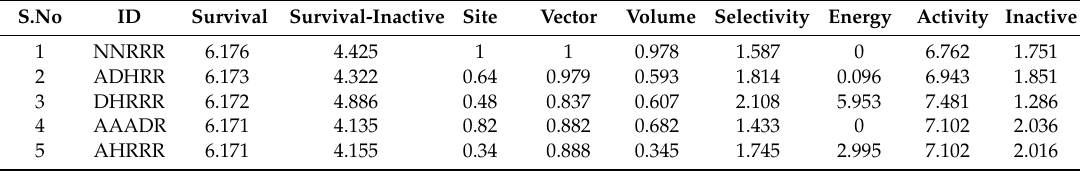
Table 1. Di ff erent score values obtained from the generated hypothesis.